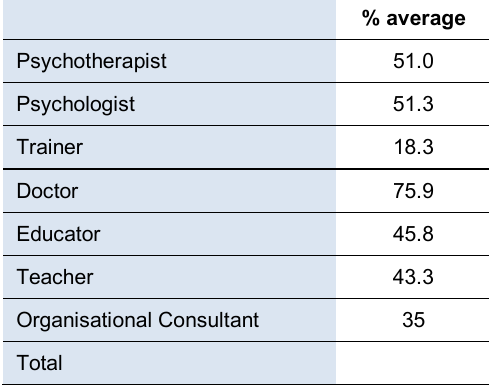
Table 4 - Time dedicated by the interviewees to each